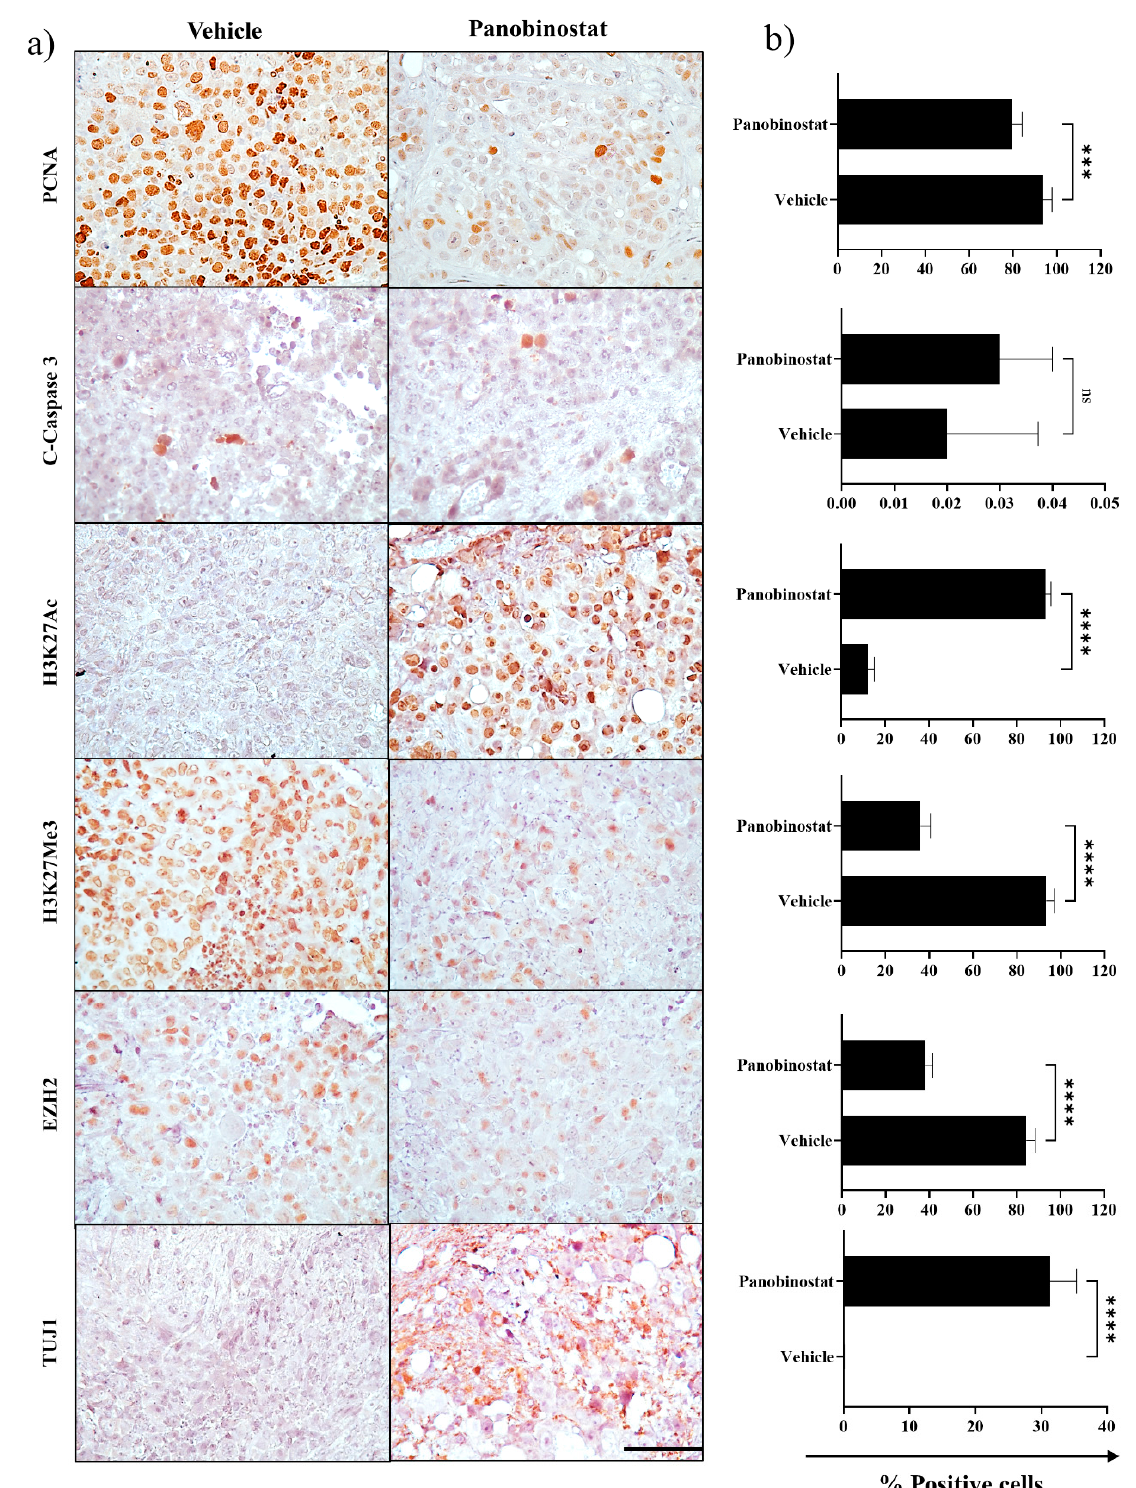
Figure 6. Immunohistochemical analysis of tumours from the BT12 Luc-GFP orthotopic xenograft model following sustained treatment with panobinostat or vehicle control. ( a ) Immunohistochemical analysis for PCNA, C-Caspase 3, H3K27Ac, H3K27Me3, EZH2 and TUJ1. Scale bar = 200 μ m. ( b ) Quantitation of immunohistochemical staining ( n = 7; mean ± SEM; ****, p < 0.0001).